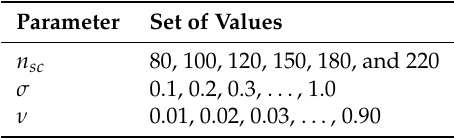
Table 2. Values considered for the proposed